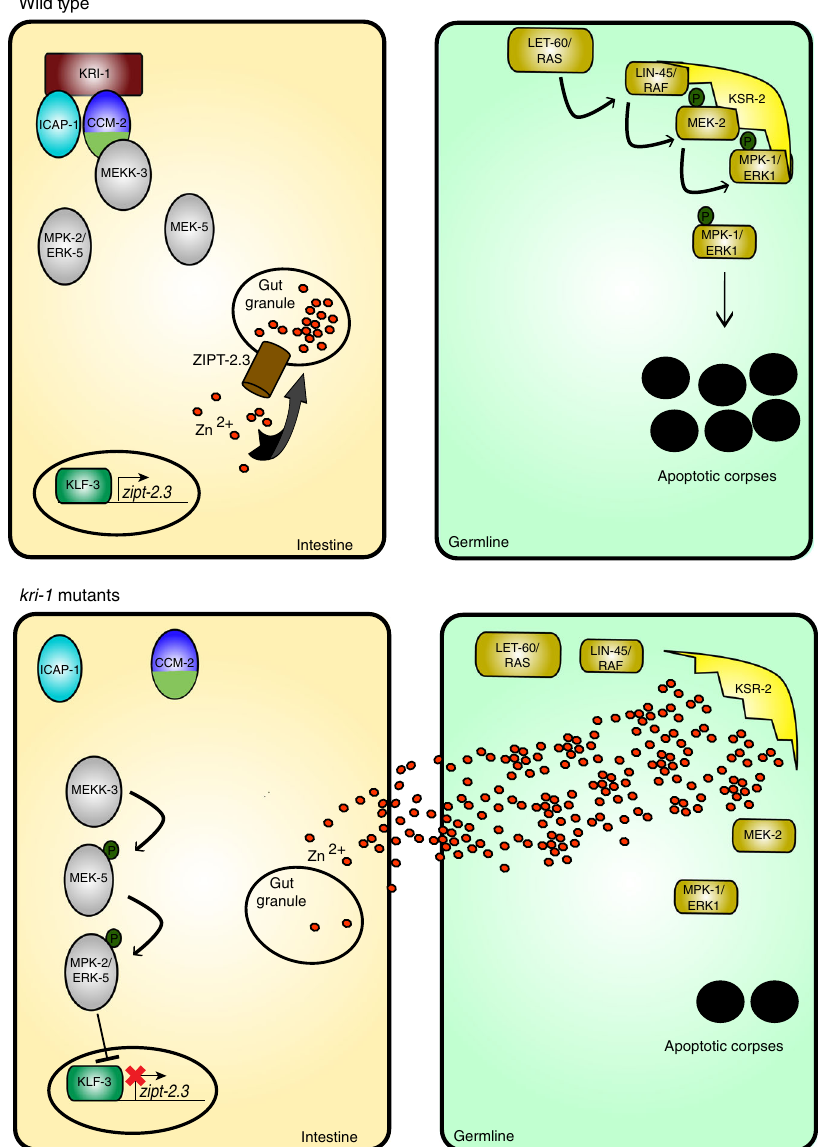
Fig. 7 KRI-1 promotes IR-induced apoptosis by regulating zinc. Schematic depicting the mechanism by which intestinal KRI-1 regulates germline MPK-1 and apoptosis. KRI-1 in complex with CCM-2 prevents the over-activation of MPK-2, allowing the transcription of zipt-2.3 by KLF-3. ZIPT-2.3 ensures the storage of zinc in the intestinal gut granules, which permits MPK-1 activation to promote